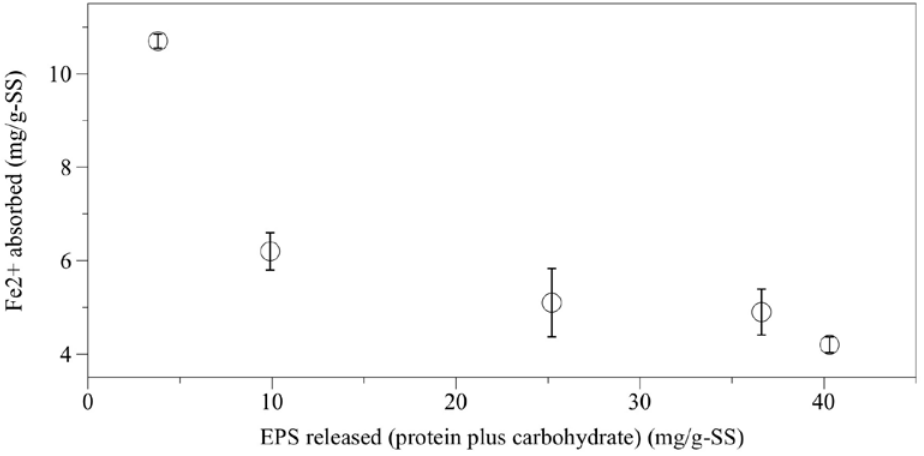
Figure 3. Relationship between Fe 2+ absorbed to granules and the extracellular polymeric substance (EPS) released after the batch experiment with sulfide (0–700